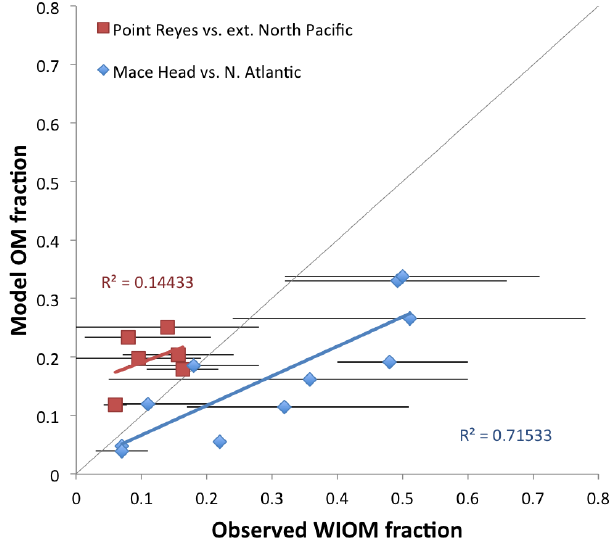
Figure 14. Observed monthly mean WIOM / (WIOM + SS) vs. modeled monthly mean OM SSA fraction, averaged over a re- gion upwind of the respective measurement location. Observations shown are: (1) sub-1.5µm WIOM fraction from a coastal site at Mace Head, Ireland (N = 42 filters collected during the years 2002– 2009), filtered for clean marine conditions (as described in Rinaldi et al., 2013) and (2) sub-2.5µm WIOM fraction from a buoy lo- cated near Point Reyes, California (N = 10 filters collected during the years 2000–2007), during clean conditions as determined by low BC concentrations (as in Gantt et al., 2011). Observations have been grouped into month-of-year means for appropriate comparison with model results. Error bars show the range of observations for each month. Model OM fractions are calculated over the North Atlantic region (as indicated in Fig. 9) and extended North Pacific region, respectively. Linear regressions and their corresponding R 2 values are shown for each data set. The 1:1 line is indicated in